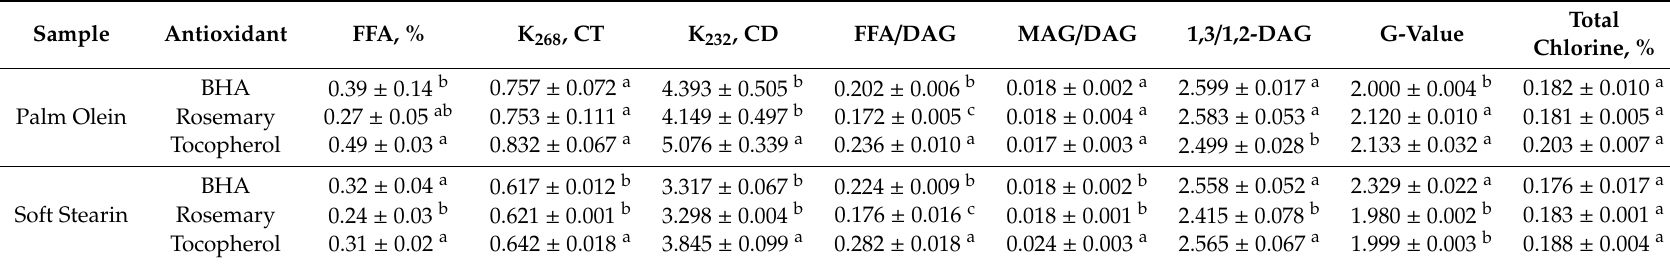
Table 2. E ff ects of di ff erent antioxidants (200 ppm) on the FFA content, specific extinction value and acylglycerol composition in the fats portion extracted from cake baked at 160 ◦ C for 20 min with di ff erent